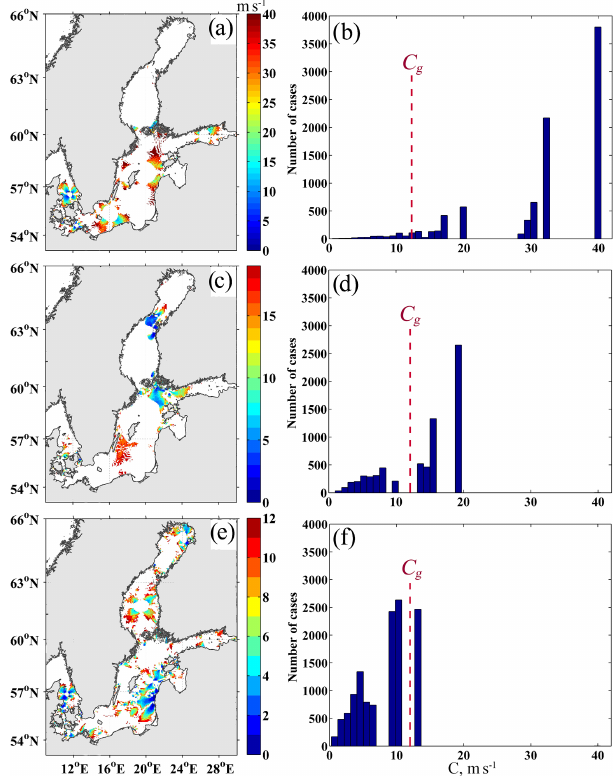
Figure 8. Maps and histograms of phase speed of barotropic progressive–standing waves of 13h (a, b) , 27h (c, d) , and 41h (e, f) periods. In the regions coloured in white, the estimated phase speed is equal to zero. The dashed line on the histogram plots indi- cates minimum theoretical value of phase speed of barotropic grav- ity wave ( C g